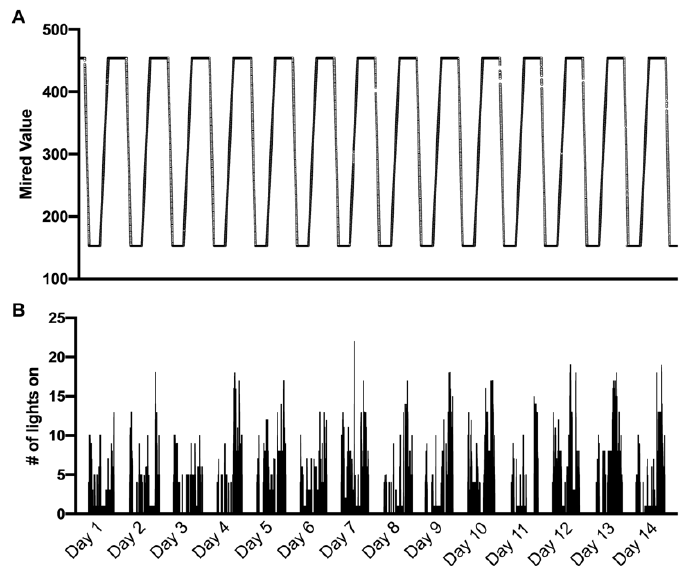
Figure 3. Mired values from home 1286 showing the programmed cycle of light spectral changes over the course of 24 h between February and March 2020 ( A ), with the number of light fixtures turned on (maximum of 22) at a 1-s resolution corresponding to the same timespan between February and March 2020 ( B ). This shorter timescale improves visualization within panel B; however, these data were collected continuously.